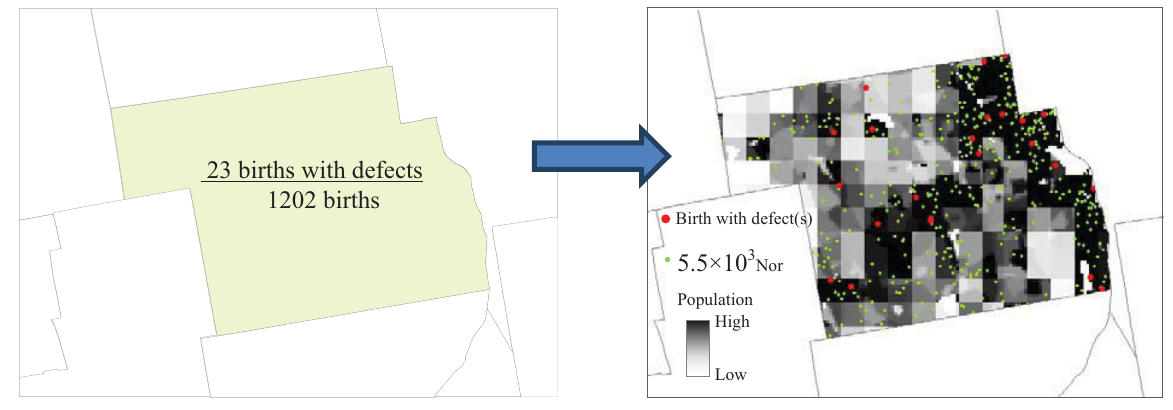
Figure 1. Disaggregation using the restricted and controlled Monte Carlo